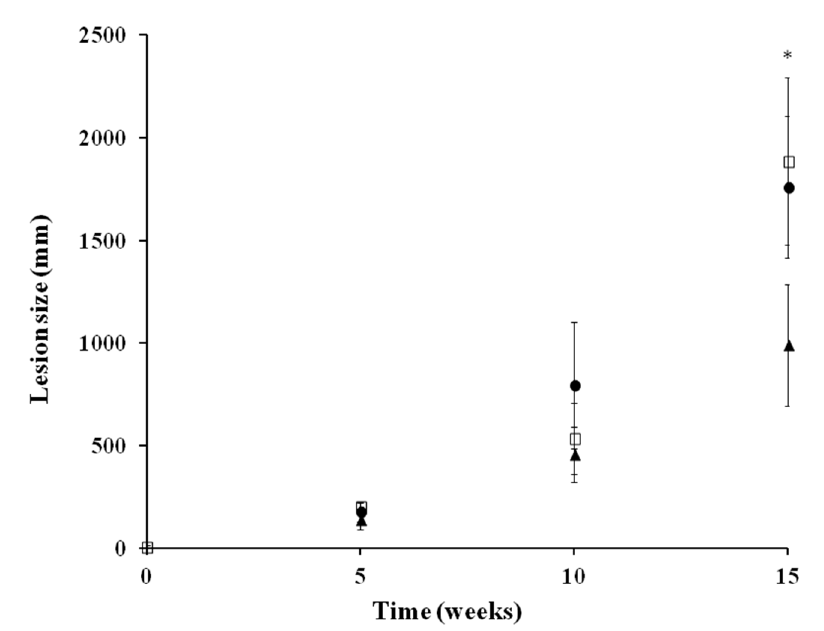
Figure 2. In vivo antileishmanial efficacy of UA ointment and cream against L. amazonensis in a chronic infection model of CL in hamsters. After 35 days post-infection, treatment with UA was topically administered once daily for 28 consecutive days. The first group received UA ointment (0.5%). The second group received UA cream (0.5%), and the third group was left untreated. Lesion size (mean ± SD) is expressed as the difference between the diameter (mm) of the infected left hind paw and the non-infected right hind paw from each animal. Statistically significant differences ( p < 0.05) are expressed as: * (U-Mann–Whitney). Key: UA ointment at 0.5% (- (cid:78) -); UA cream at 0.5% (- • -); untreated